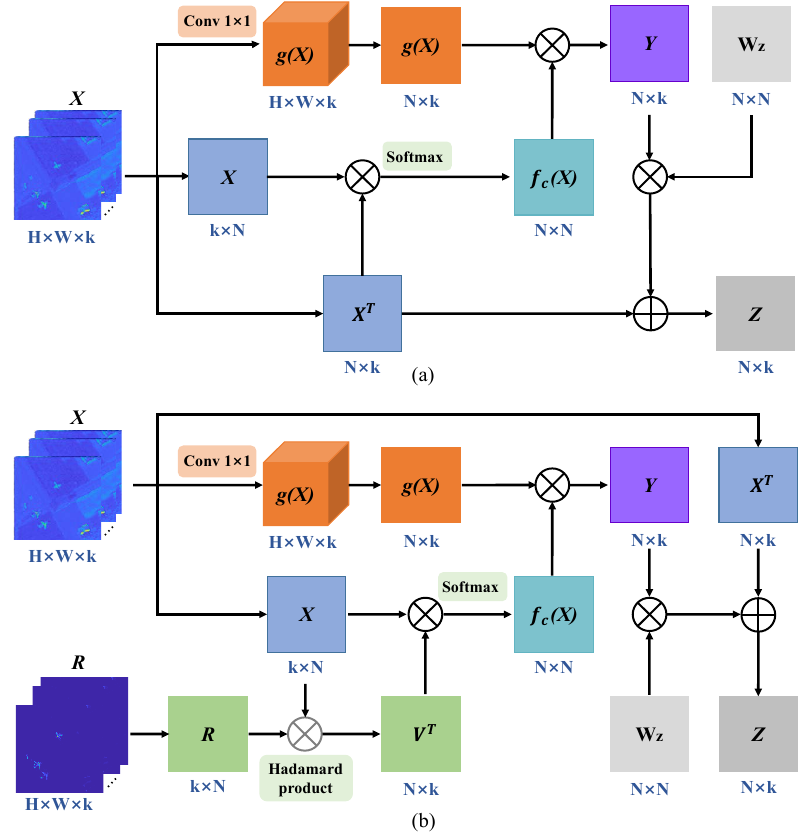
Figure 5. ( a ) Original non-local network with input of X . ( b ) Improved rNon-local in proposed method with input of X and residual R